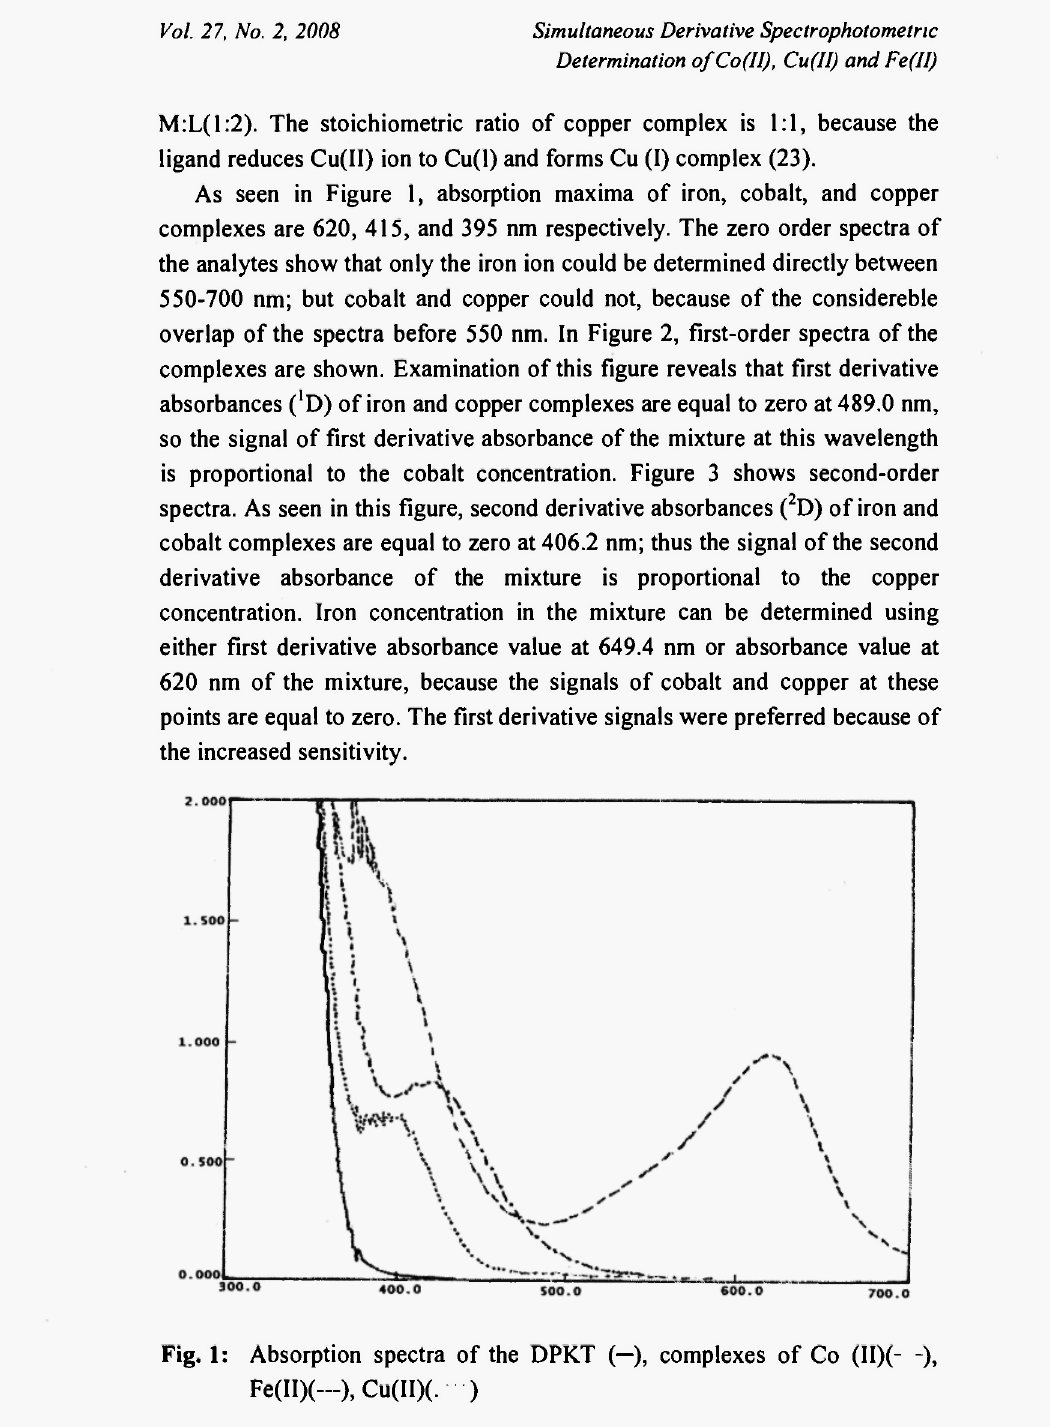
Fig. 1: Absorption spectra of the DPKT (—), complexes of Co (II)(- -), Fe(II)(-),